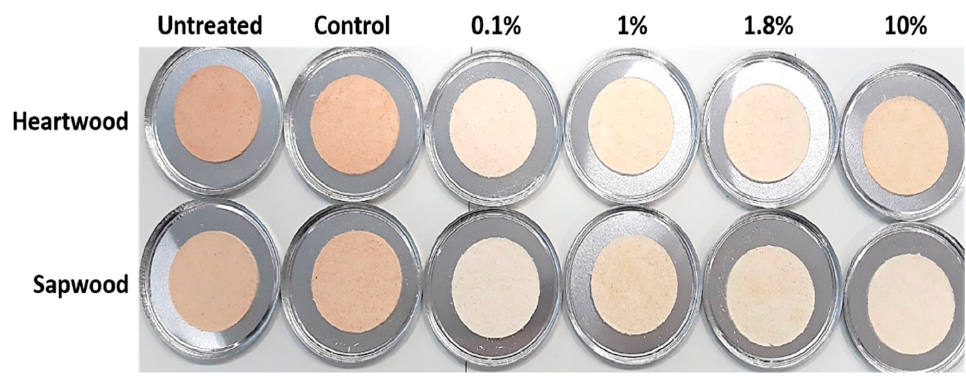
L* parameter (Figure 6a): there is no significative difference between the experiments for heartwood. For sapwood on the other hand, L* values decrease with the increase a* parameter (Figure 6b): For heartwood as for sapwood, all values decrease com- pared to untreated powders but with no significative influence of NaOH concentra- tion. The lowest difference is obtained for 1%w. • b* parameter: Values are strongly dependent on NaOH percentage shown in Figure 6c and keep increasing with the concentration, especially for heartwood samples. Consequently, wood powders treated with a solution containing 10% NaOH look more yellow than the others as shown in Figure 6.